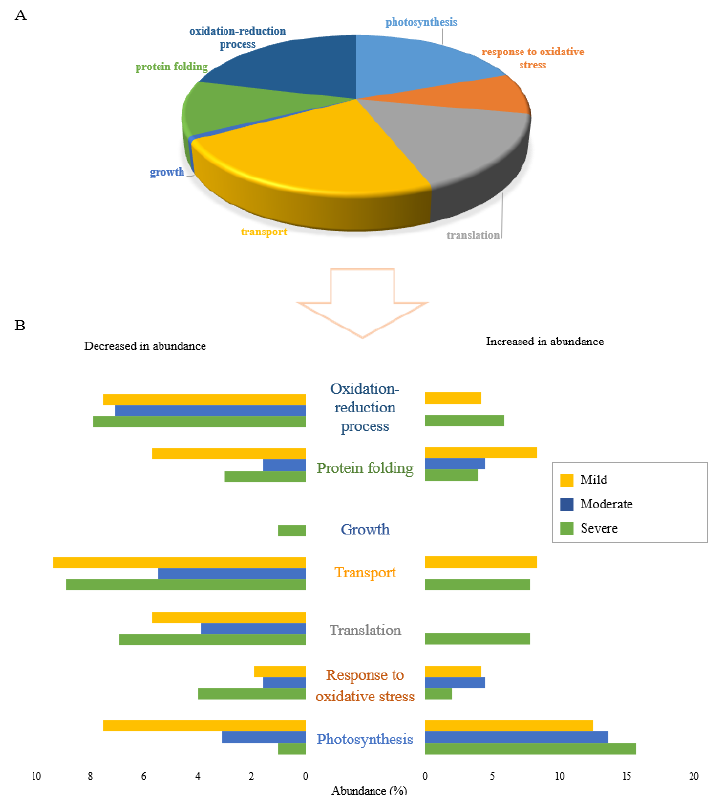
Figure 3. Functional classification of proteins differentially accumulated in response to drought stress levels, specific to each of severe, moderate, and mild drought stresses. ( A ) The pie chart shows the percentage of biological functions of 378 proteins significantly changed uniquely under different drought stress levels. ( B ) The bar graph shows the abundance of proteins in percentage in 7 func- tional categories that are uniquely altered in response to drought stress levels including severe, moderate, and mild drought treatments. Distinct colours represent various levels of field capacity in drought stress: severe drought specific (green), moderate drought specific (blue) and mild drought specific (yellow).